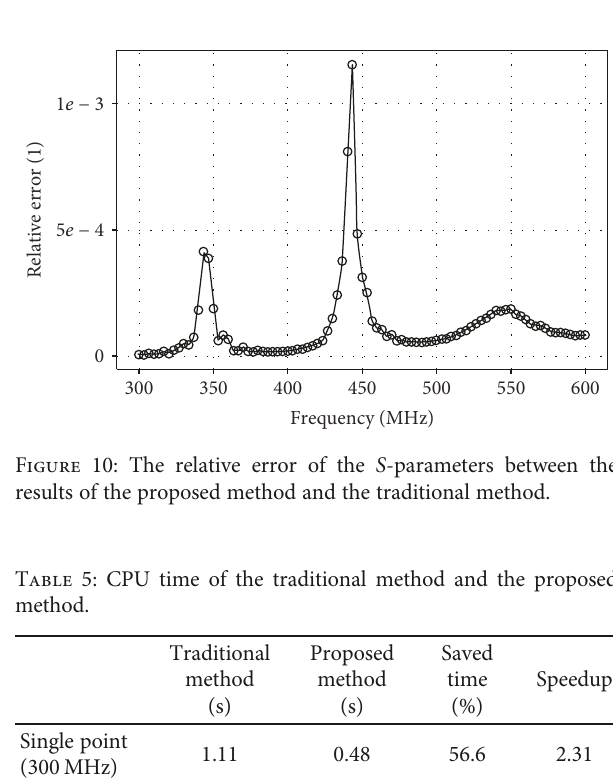
Figure 9: S -parameter of the Archimedes spiral antenna.